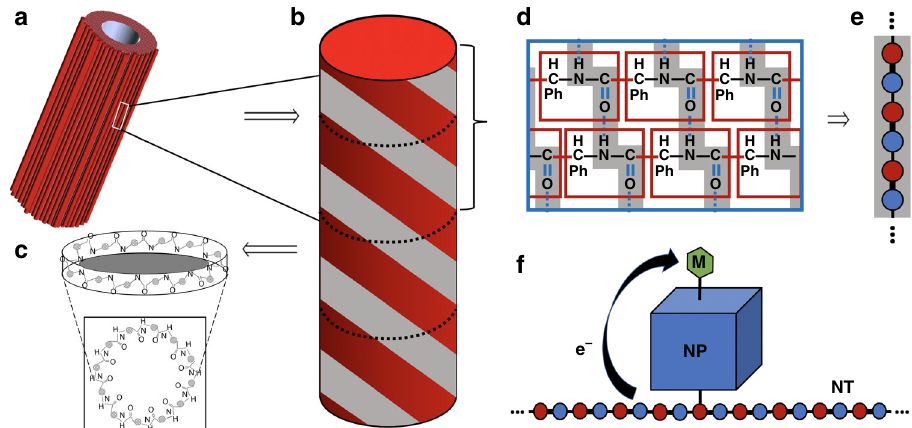
Fig. 4 Schematic formulation of reduced theoretical model. a Self-assembled FF-PNT superstructure of ( b ) individual tubes, each of which is built up from ( c ) stacked six-fold macrocycles (FF comprises a ring of 6 diphenylalanine units). d The FF units in adjacent layers are hydrogen bonded, resulting in ( d ) the corkscrew structure and longitudinal chains with alternating strong (C = O) and weak (O … H) bonds. e Reduced model for the FF-PNT consisting of a single 1d chain with alternating couplings. f Model for the entire system, with the target molecule attached to a metallic NP, which itself is coupled to the NT chain